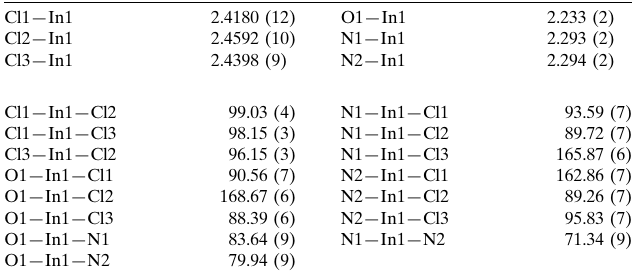
Selected geometric parameters (A˚ , (cid:2) ).